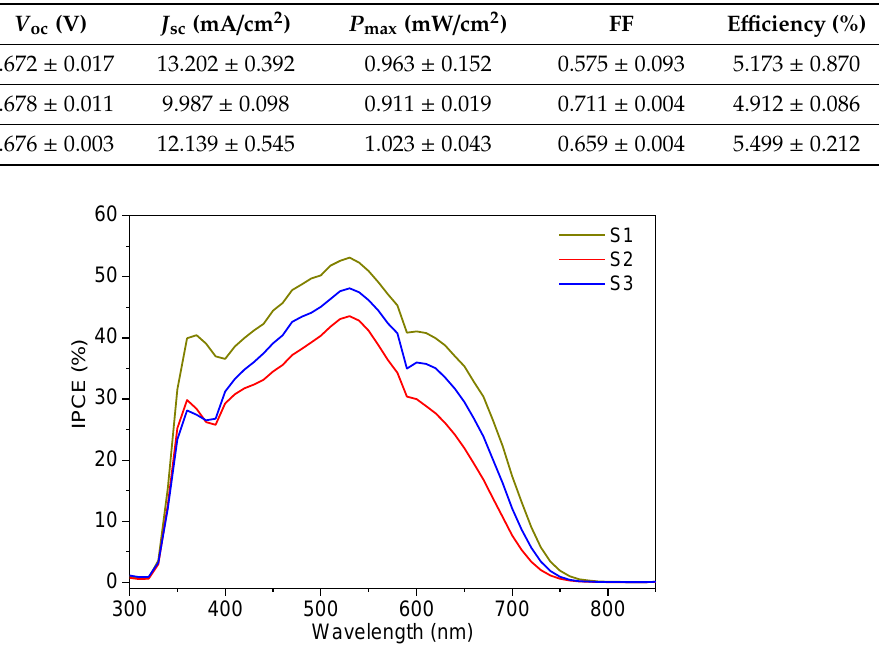
Figure 5. Incident Photon-to-Current Conversion E ffi ciency (IPCE) spectra for DSSCs fabricated using S1, S2, and S3